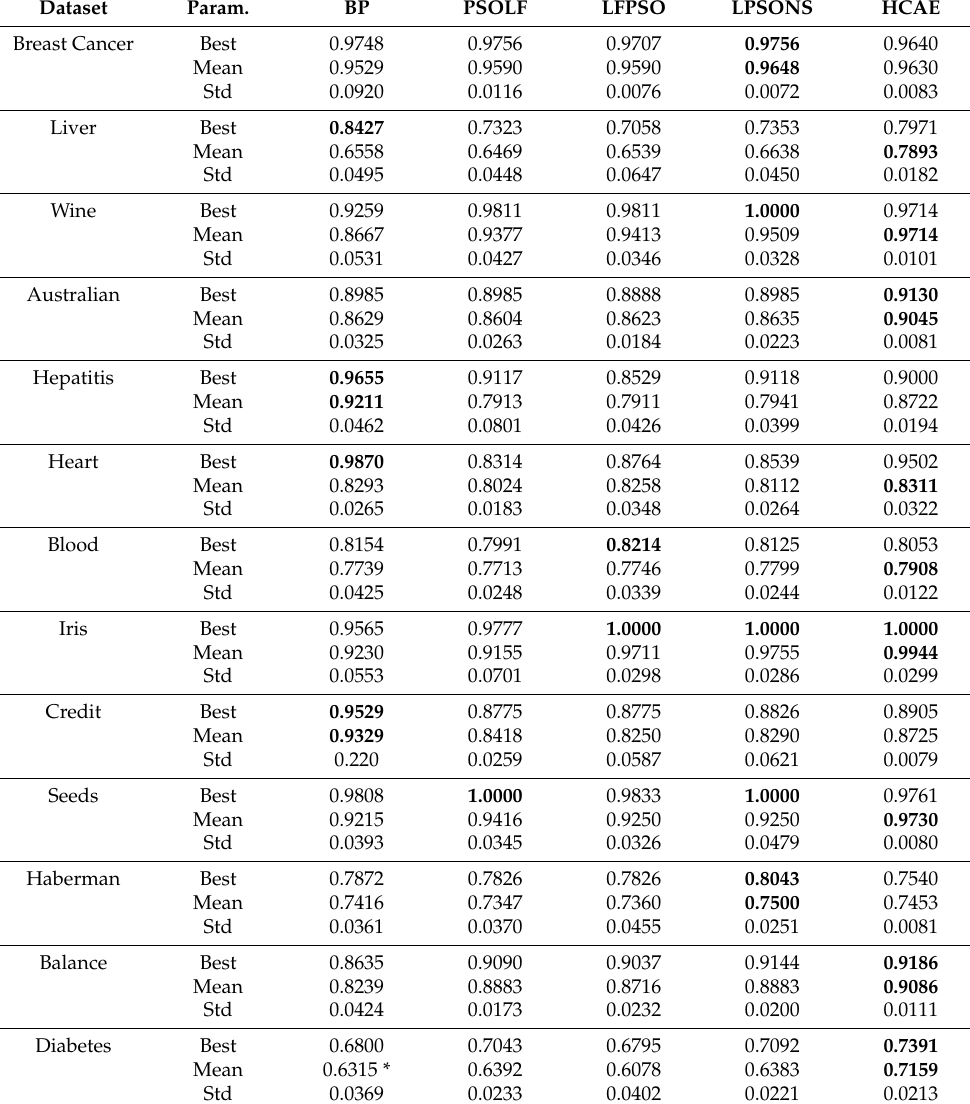
Table 9. Classification testing accuracy (results of BP, PSOLF, LFPSO, and LPSONS taken from [27], * —a table in [27] includes a value 0.7315 instead of 0.6315, however, due to the fact that 0.7315 is greater than 0.68 which is the best value for Diabetes dataset, the value 0.7315 was considered to be a typo and it was replaced with